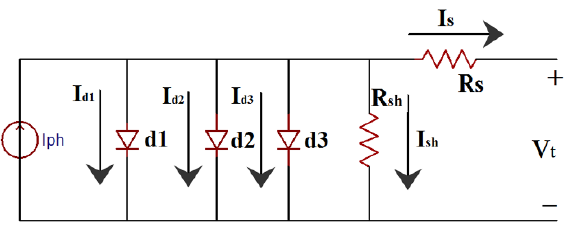
Figure 2. Double-diode model.